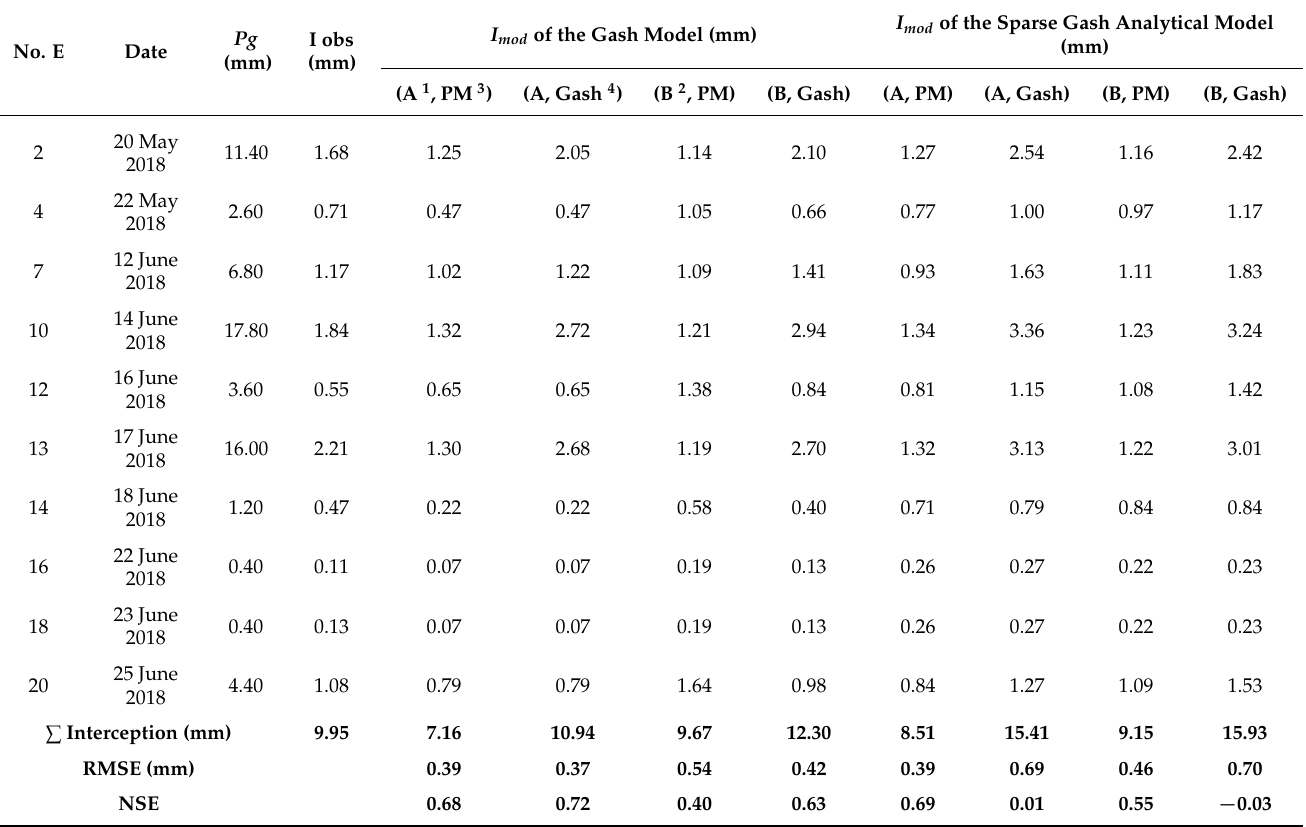
Table 9. Values of the interception observed ( I m ) and modeled ( I mod ) for P. hartwegii with the combinations of the meteoro- logical and canopy